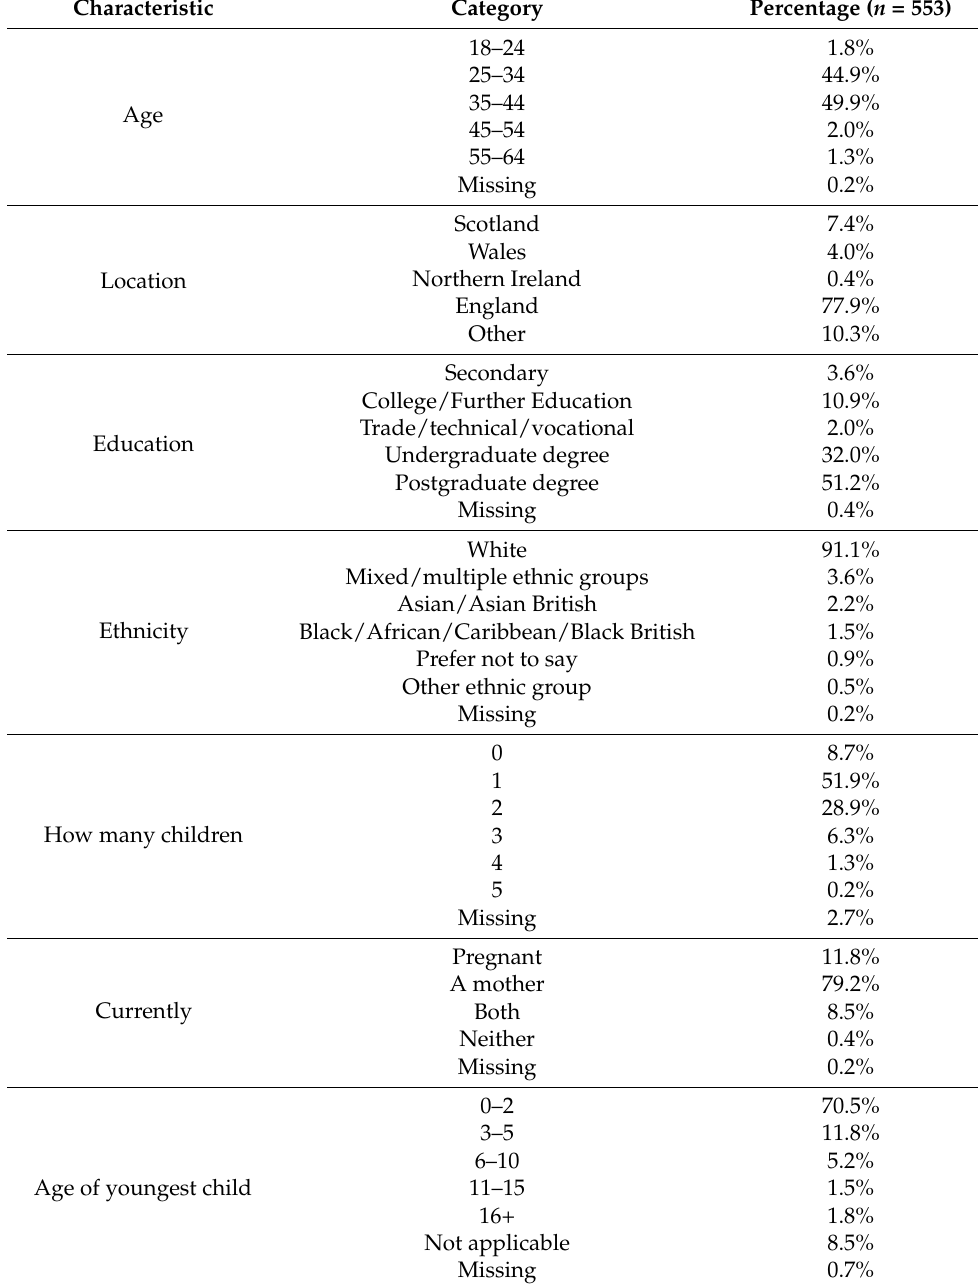
Table 1. Characteristics of survey